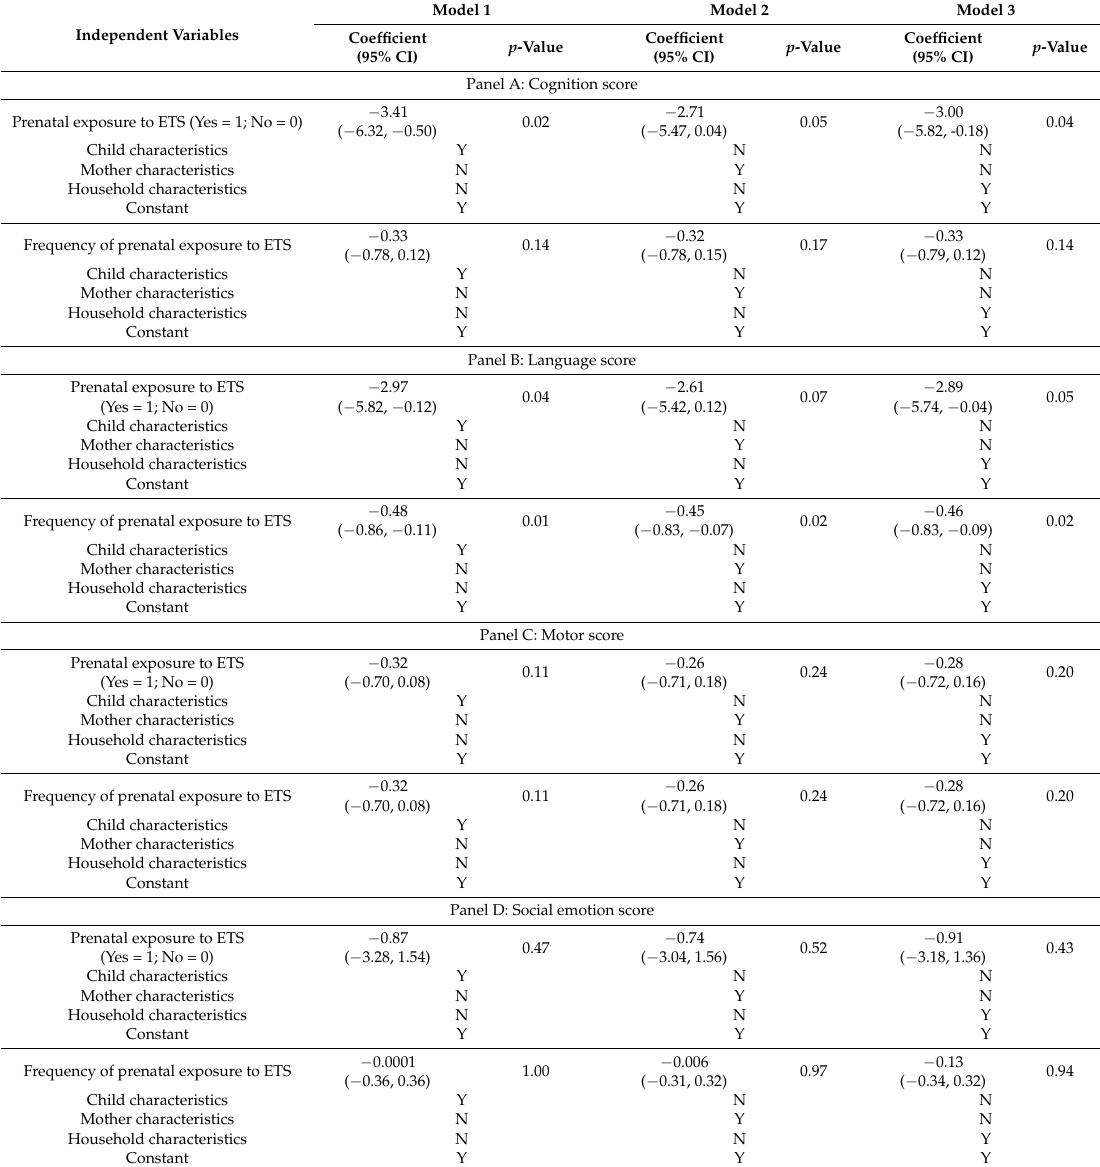
Table A3. Results of regressions with different confounding variables on early development of children in rural Guizhou